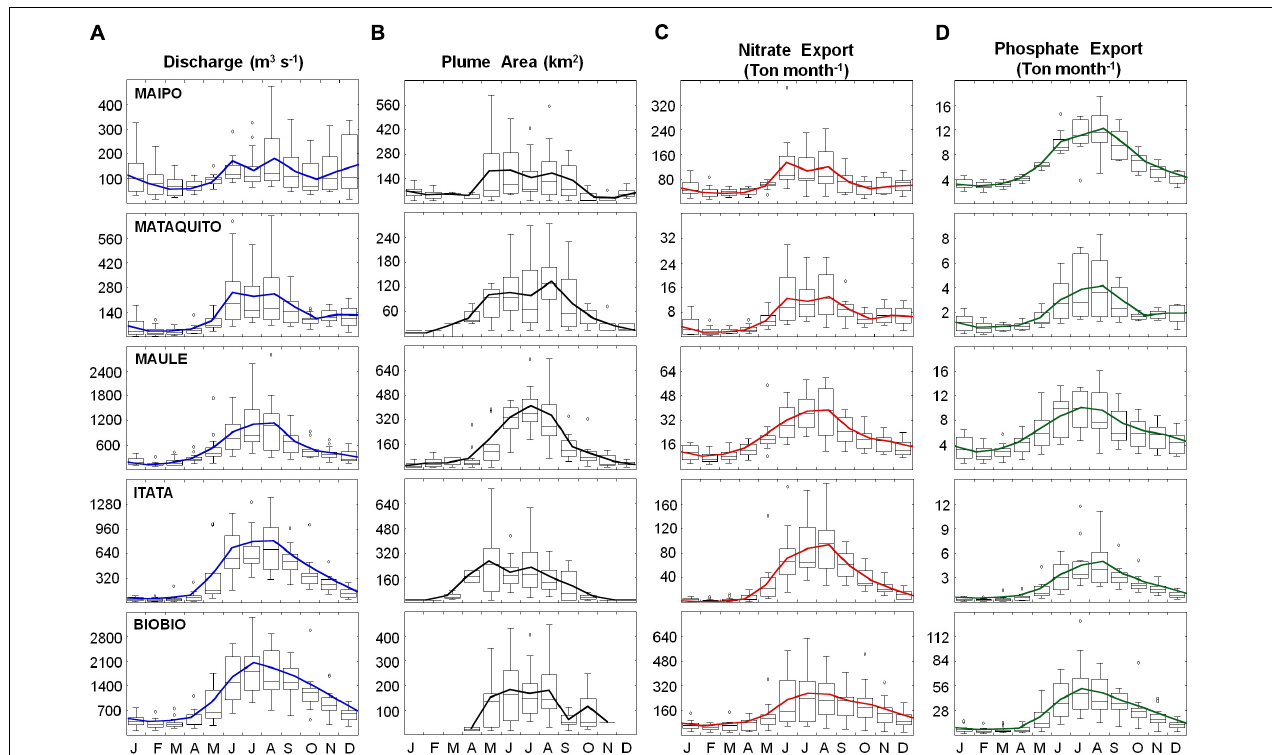
FIGURE 3 | Seasonal cycles of (A) river discharge (m 3 s − 1 ), (B) satellite-derived river plume area (km 2 ), (C) nitrate- NO 3 − and (D) phosphate-PO 4 − 3 export (Ton month − 1 ) for the Maipo, Mataquito, Maule, Itata, and Biobío rivers. Solid colored lines correspond to the monthly mean value.